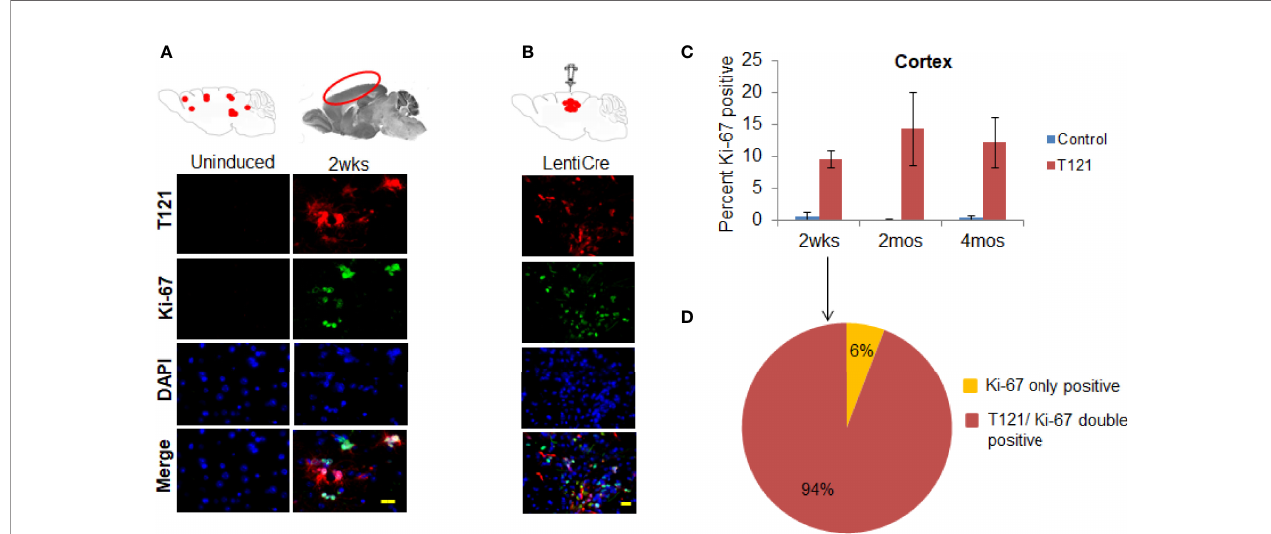
FIGURE 2 | T 121 and Ki-67 staining and quantitative analysis in the cortex. (A) Immuno fl uorescence images of brain sagittal sections of 3 month old mouse induced with intraperitoneal injection of 4OHT for 2wks post induction and uninduced brain section as control. Cartoons at the top represent global induction events of T 121 and the cortical area being visualized in the fl uorescent images. Images of the cortical area have T 121 in red, Ki-67 in green, merge and nuclei counterstained DAPI is blue. Scale bar indicates 20 micron. (B) Immuno fl uorescence images of brain sagittal sections of a 3 month old mouse with focal induction using lentiCre for 2wks post induction. Cartoons at the top represent focal induction events of T 121 in the cortex. Images of the cortical area have T 121 in red, Ki-67 in green, merge and nuclei counterstained DAPI is blue. Scale bar indicates 20 micron. (C) Quantitative analysis of Ki-67 positive cells in the cortex. Histogram of percent Ki-67 positive cells in the cortex from control and T 121 induced mice at different time points -2wks, 2mos and 4mos post induction. Blue bars- Control mice, Red bars- T 121 induced mice. N-5 mice and 3000 cells from 6 random fi elds/mouse. (D) Pie chart depicting the overlap between Ki-67 and T 121 positive cells from a 2wks post T 121 induced cortex. 1200 Ki-67 positive cells from 50 different fi elds and 6 mice were visualized for an overlap with T 121